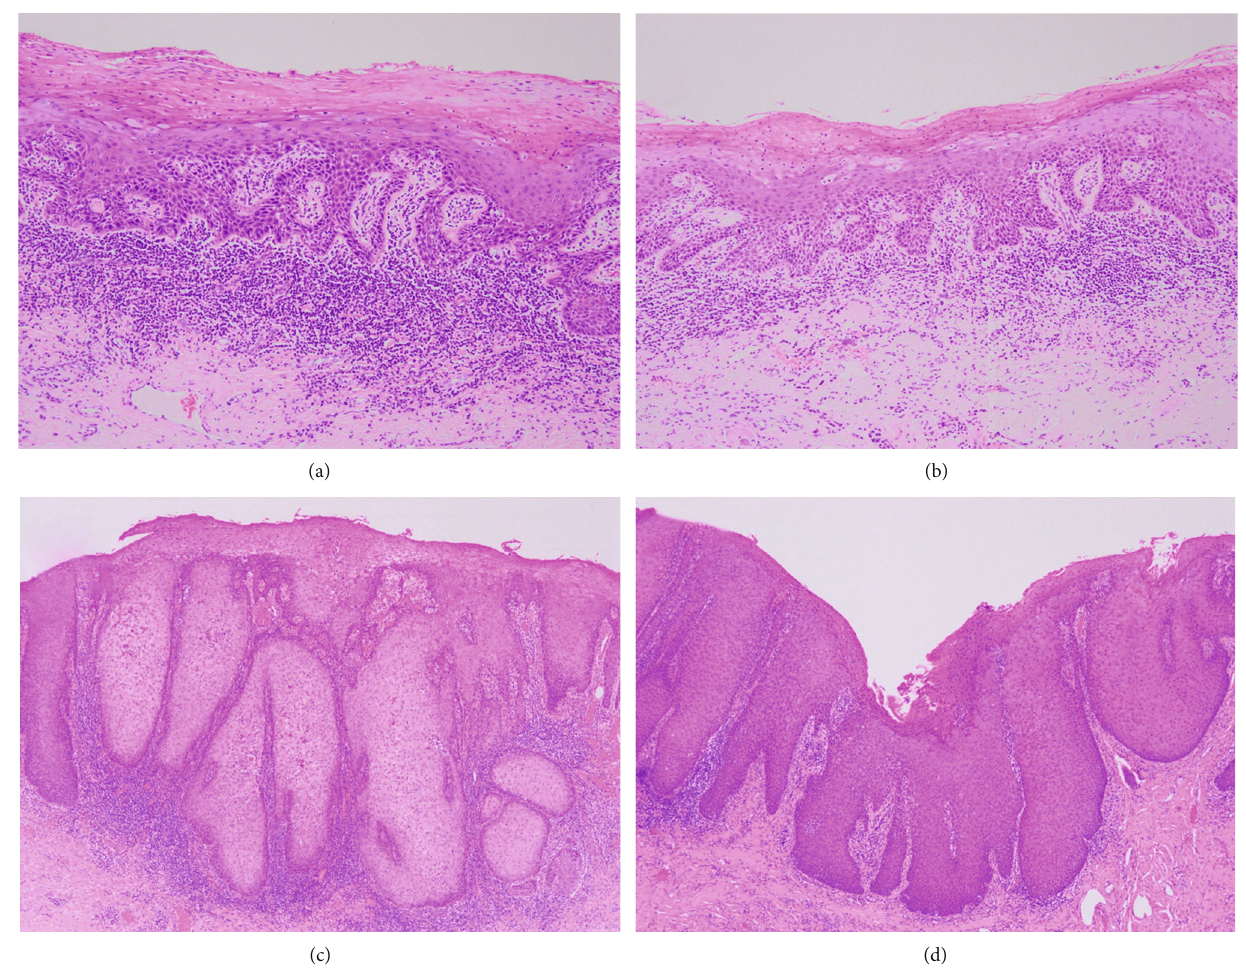
Figure 2: Photomicrographs of surgical specimens. (a) Specimen of tongue showing severe dysplasia. (b) Specimen of the right buccal mucosa showing severe dysplasia. (c) Specimen of the right side of lower lip showing squamous cell carcinoma. (d) Specimen of the right palatal gingiva showing carcinoma in situ (hematoxylin-eosin stain — original magni fi cation × 100; (a and b), × 40; (c and d) × 40).